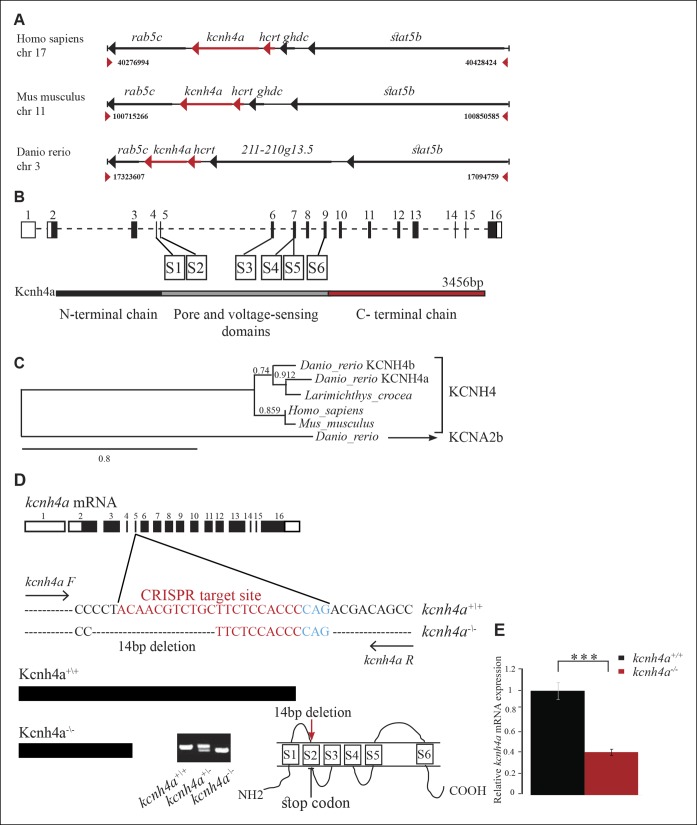
The genomic location, phylogenetic reconstruction and structure of kcnh4a, and the generation of kcnh4a-/- zebrafish.(A) Synteny analysis shows similar genomic context of hcrt in zebrafish and mammals. Notably, kcnh4a is located a few kbs downstream to hcrt in zebrafish and mammals. (B) The 16-exon kcnh4a gene (black box = exon, white box = UTR) encodes for a voltage-gated potassium channel that includes an N-terminal chain (black bar), pore and voltage-sensing domains (S1-6, grey bar), and the C-terminal chain (red bar). (C) A cladogram-style phylogenetic tree depicting the evolutionary conservation of Kcnh4a protein among vertebrates. The tree shows topography as well as distance indicated by the branch support values above corresponding branches. (D) Generation of CRISPR-mediated kcnh4a-/- zebrafish. A 14 bp deletion was introduced in exon 5 that encodes to the S2 domain. A short mutant allele was visible on agarose gel. (E) Quantitative reverse transcription PCR shows reduction of 59% in the expression levels of kcnh4a mRNA in kcnh4a-/- 6 dpf larvae (p <0.001).